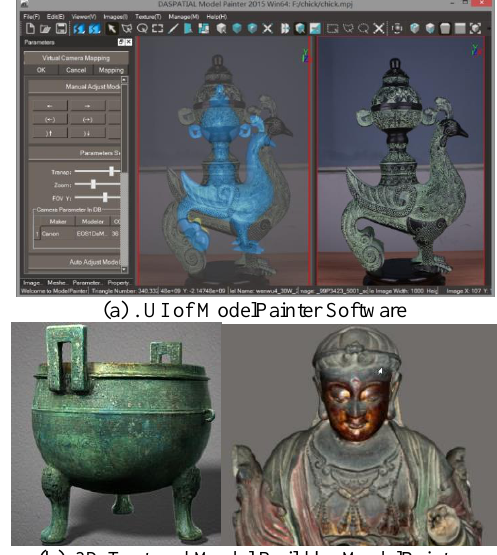
Figure 16: ModelPainter UI and the Produced 3D Model